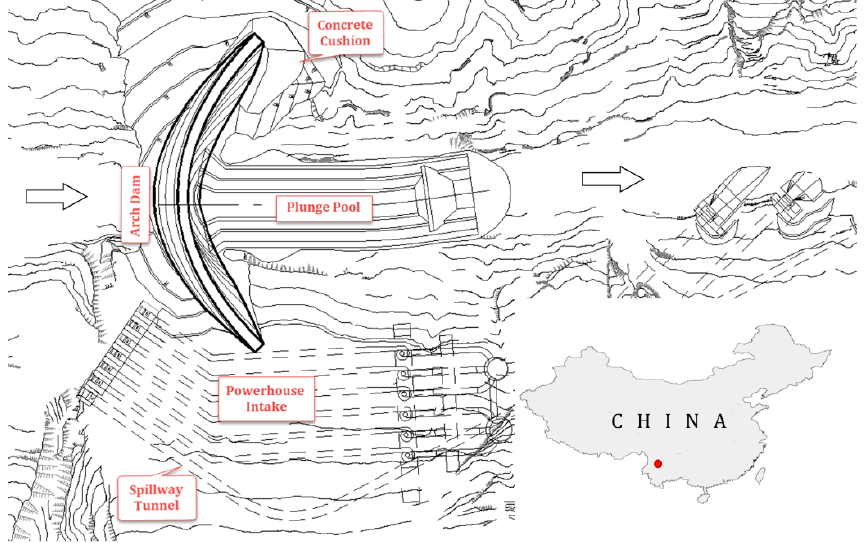
Figure 6. Layout chart of Jinping-I arch dam.